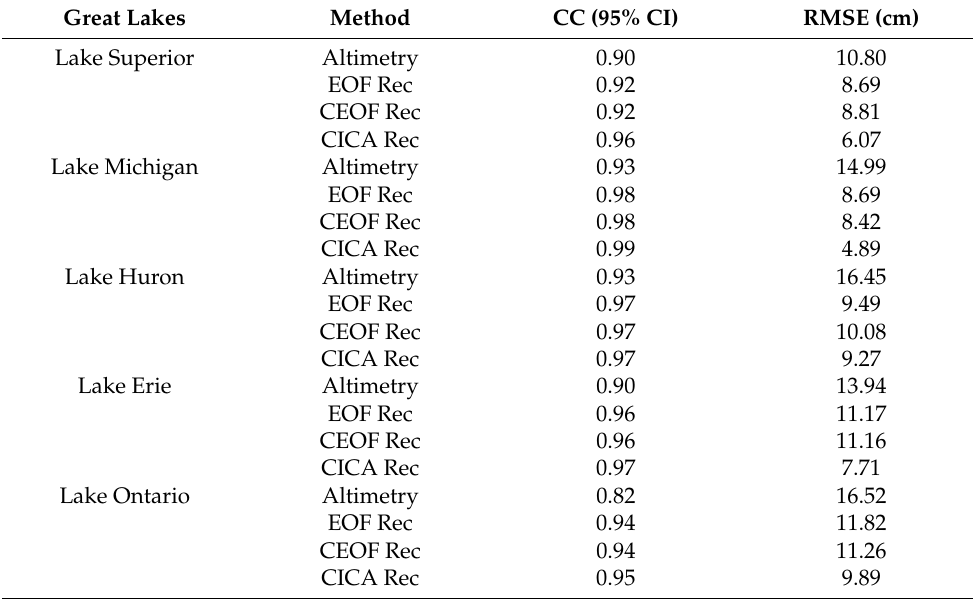
Table 2. Correlation coefficient (CC) with 95% confidence intervals (CI) and RMSE viewed as evaluation indicators to compare original altimetry data and reconstructed results. Great